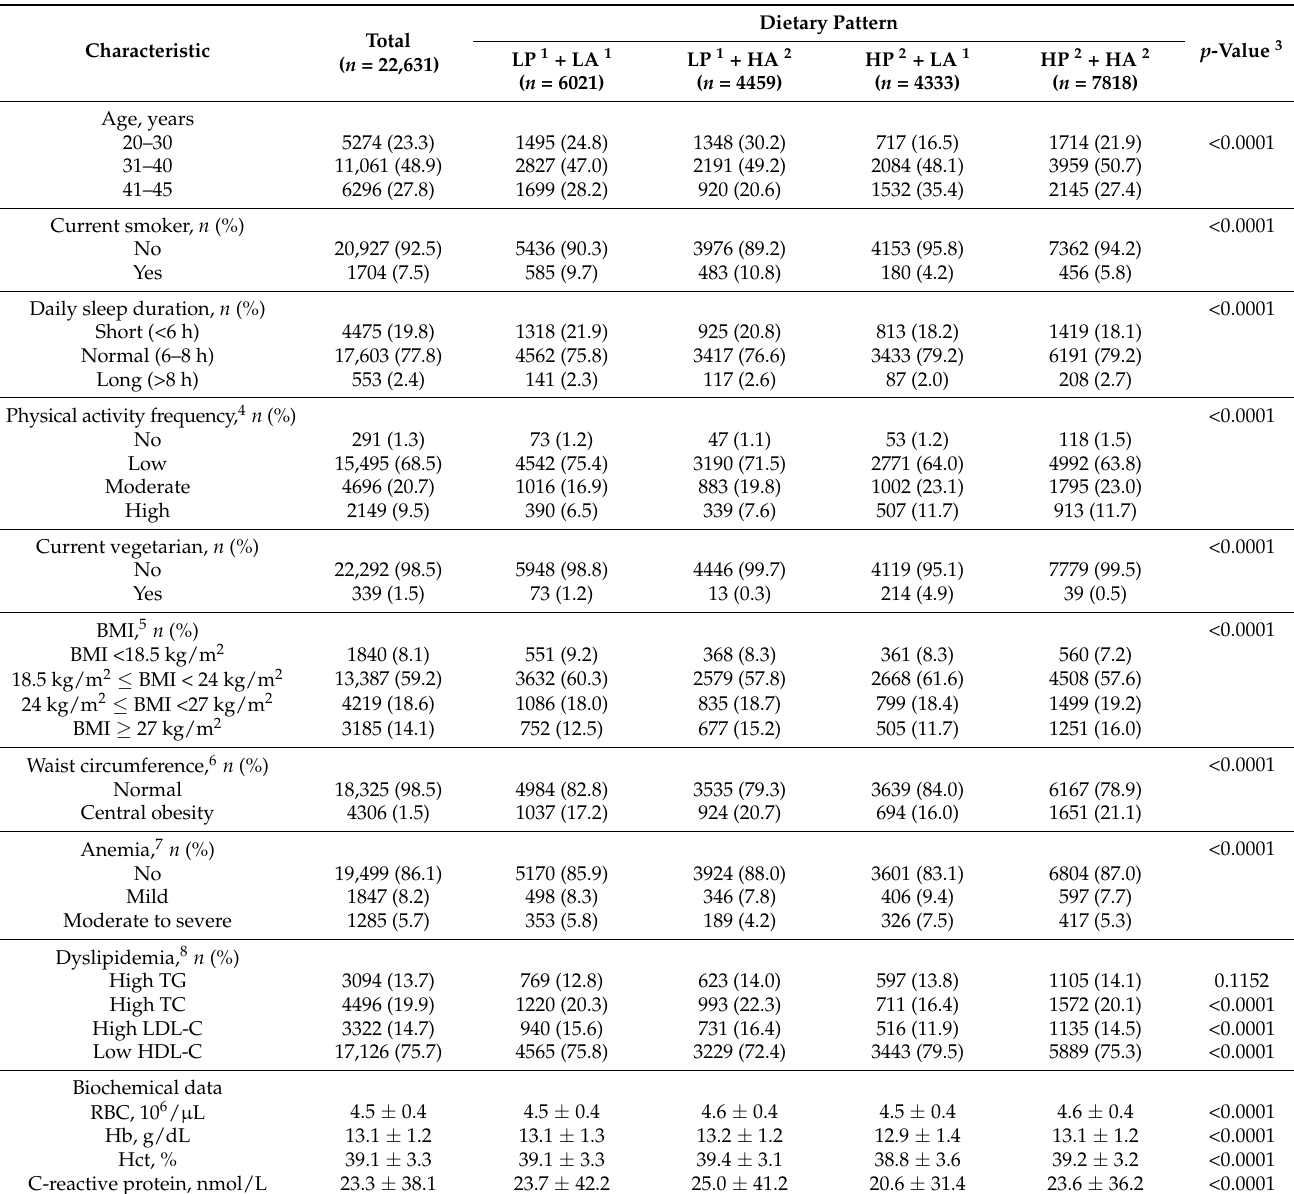
Table 1. Characteristics of dyslipidemic women aged 20–45 years ( n = 22,631) with different dietary